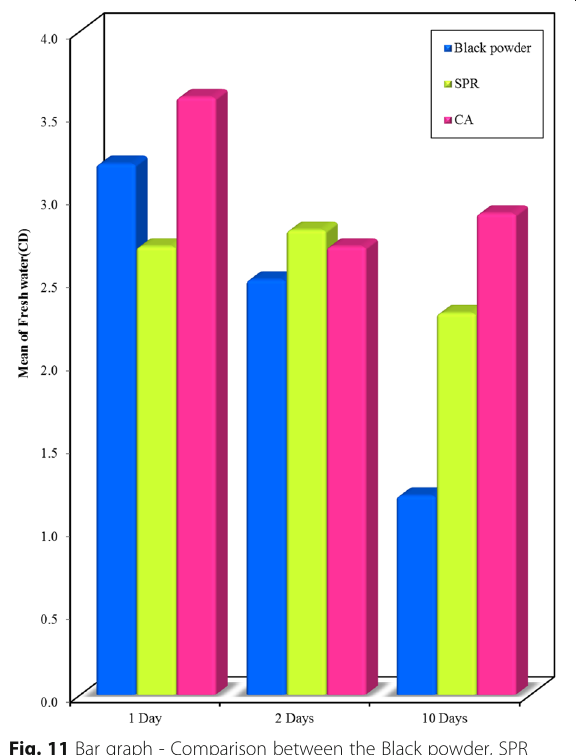
Fig. 11 Bar graph - Comparison between the Black powder, SPR and CA development techniques at different time intervals on plastic surface recovered from freshwater . It shows that highest mean visibility score of prints developed using CA